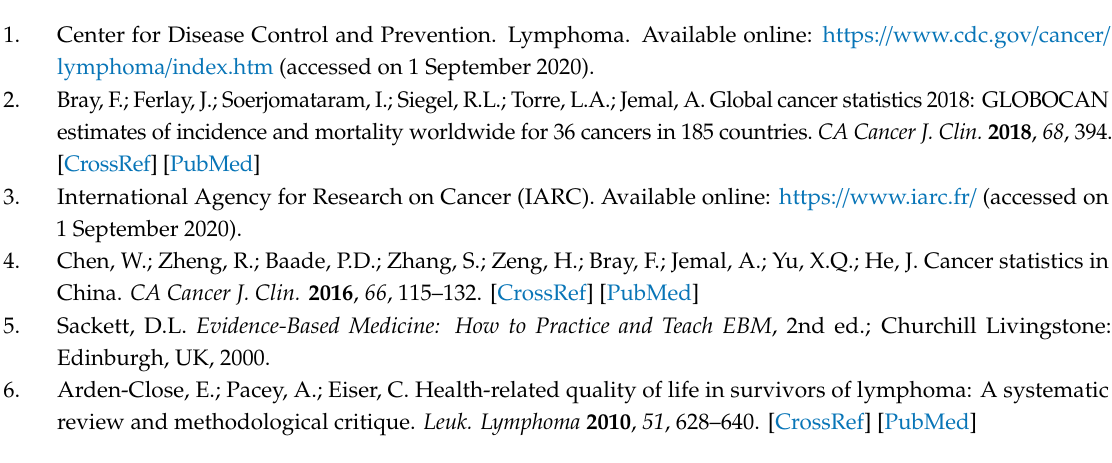
Table S1: Multivariable adjusted linear regression models of the relationship between EQ-Index and financial burdens, Table S2: Multivariable adjusted linear regression models of the relationship between physical functioning and financial burdens, Table S3: Multivariable adjusted linear regression models of the relationship between emotional functioning and financial burdens, Table S4: Multivariable adjusted linear regression models of the relationship between social functioning and financial burdens, Table S5: Comparisons between common and uncommon NHL, Table S6: Multivariable adjusted linear regression models of the relationship between HRQoL and financial burdens for patients with common NHL, Table S7: Multivariable adjusted linear regression models of the relationship between HRQoL and financial burdens for patients with uncommon